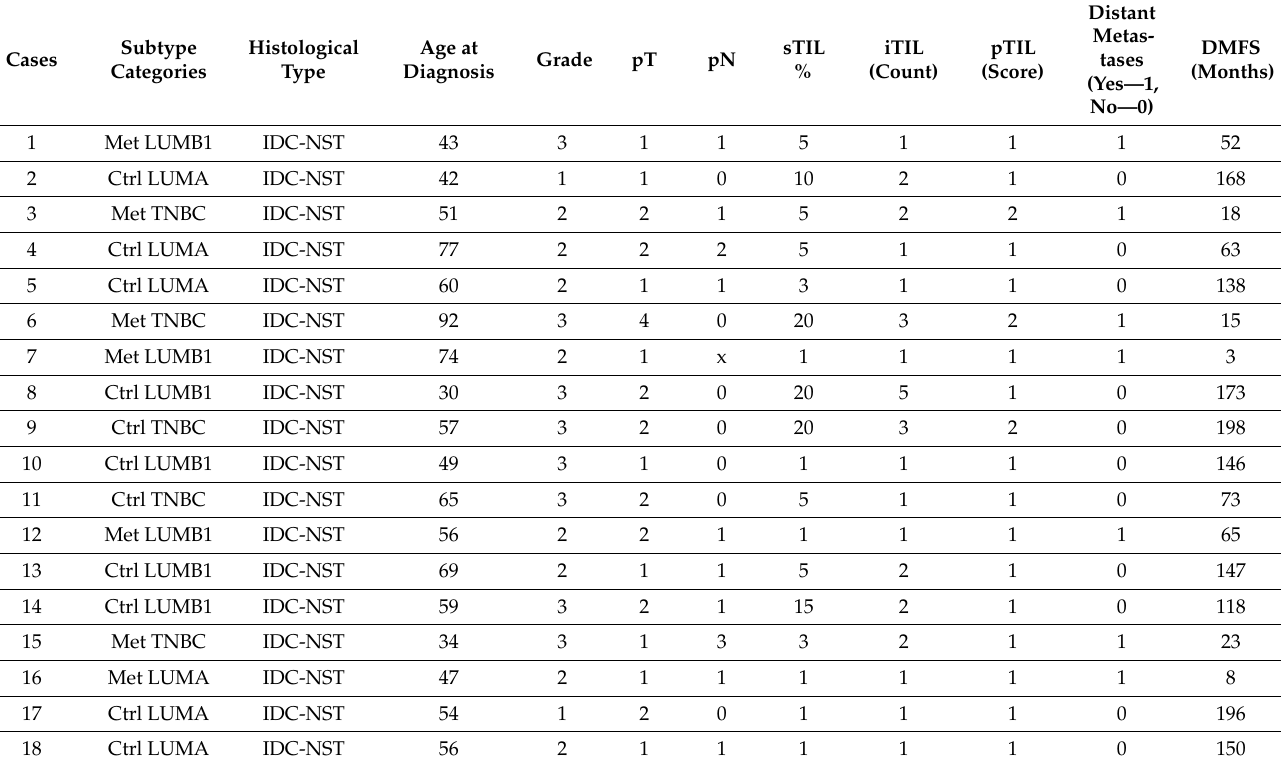
Table 2. The clinicopathological data of the 35 cases selected for immune gene expression